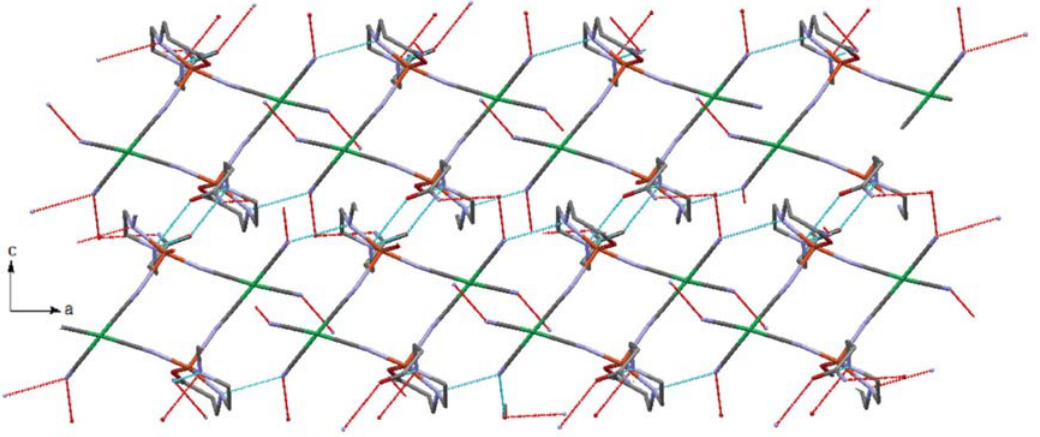
Fig. 4. Various hydrogen bonding interactions in complex 1 along ac Table 3. Hydrogen bonding (Å) and angles (°) for [ Cu(bcen)Ni(CN)